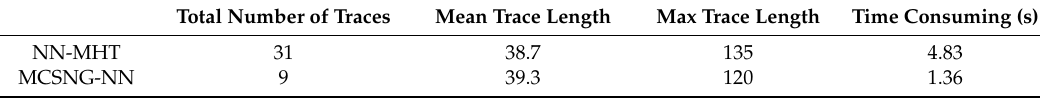
Figure 14. Tracing results of NN-MHT and MCSNG-NN: ( a ) NN-MHT tracing result; ( b ) MCSNG- NN tracing result. Table 7. The performance indexes of NN-MHT and MCSNG-NN. Table 7. The performance indexes of NN-MHT and MCSNG-NN.